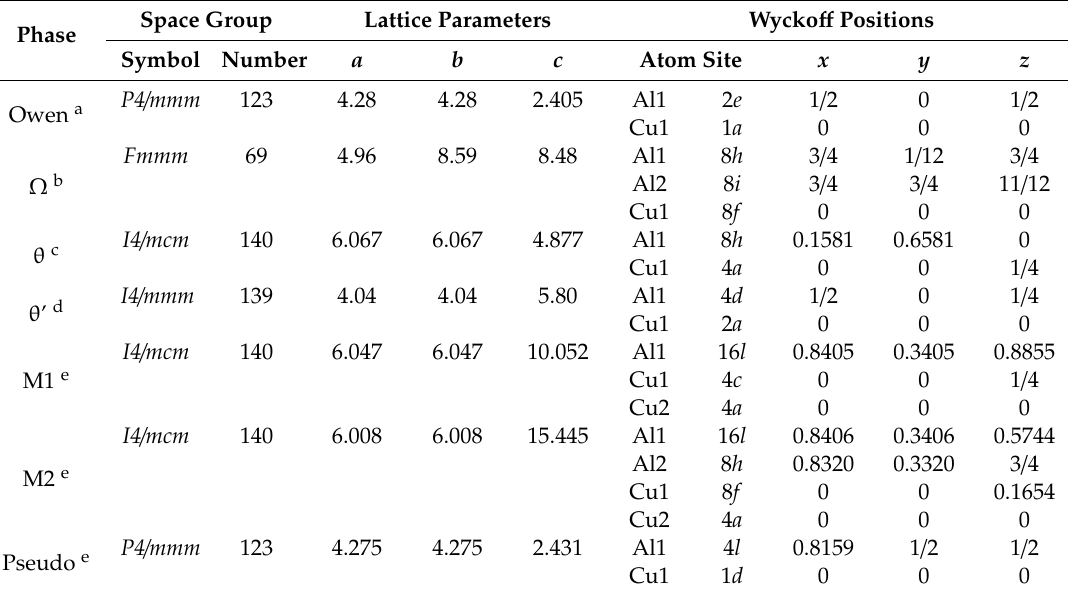
Table 1. Crystallographic information of all existing Al 2 Cu phases (the Owen-, θ -, θ ’- and Ω phase) and two proposed potential Al 2 Cu phases (M1 and M2